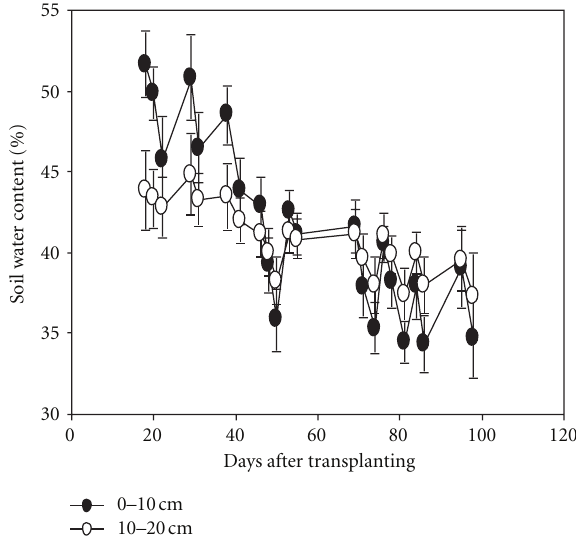
Figure 2: Change in soil water content during the growing season under AWD in 2010 DS at the IRRI farm. Data were the means across two rates and four varieties; N rate and variety had no significant e ff ect on soil water